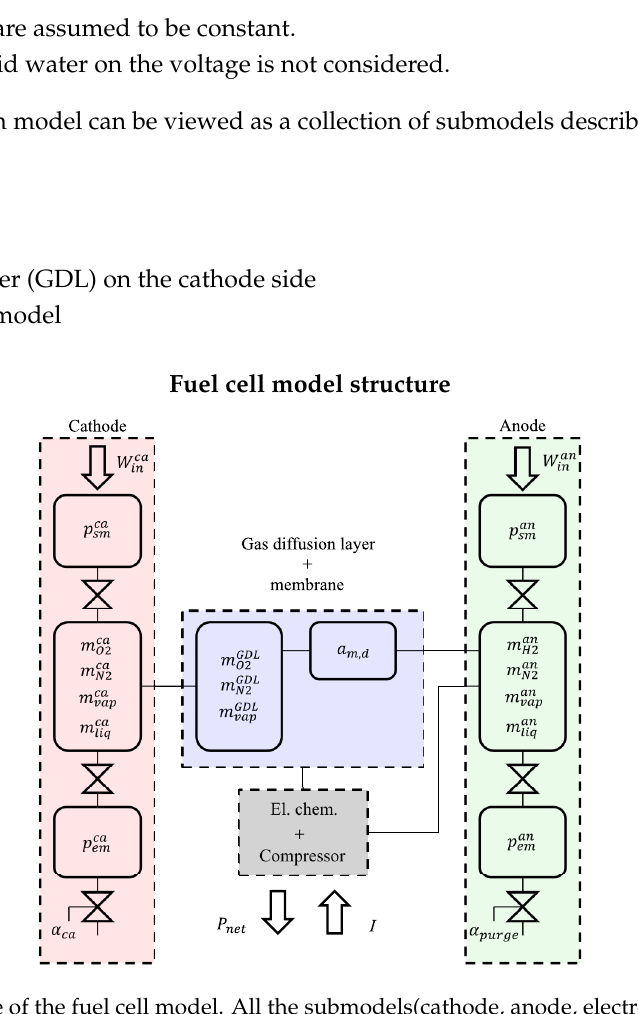
Figure 1. Structure of the fuel cell model. All the submodels(cathode, anode, electrochemical model, compressor, gas diffusion layer, and membrane) are enclosed in dashed